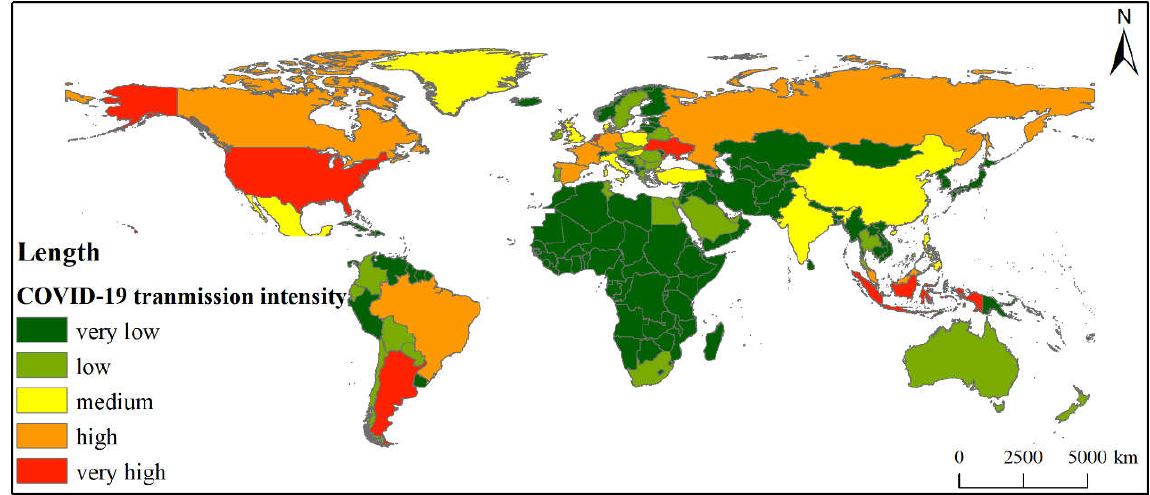
Figure 5. National of COVID-19 intensity transmission by